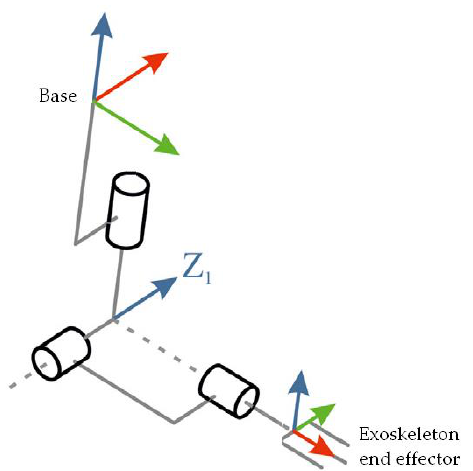
Figure 6. Kinematic structure of the elbow exoskeleton (based on [26]).